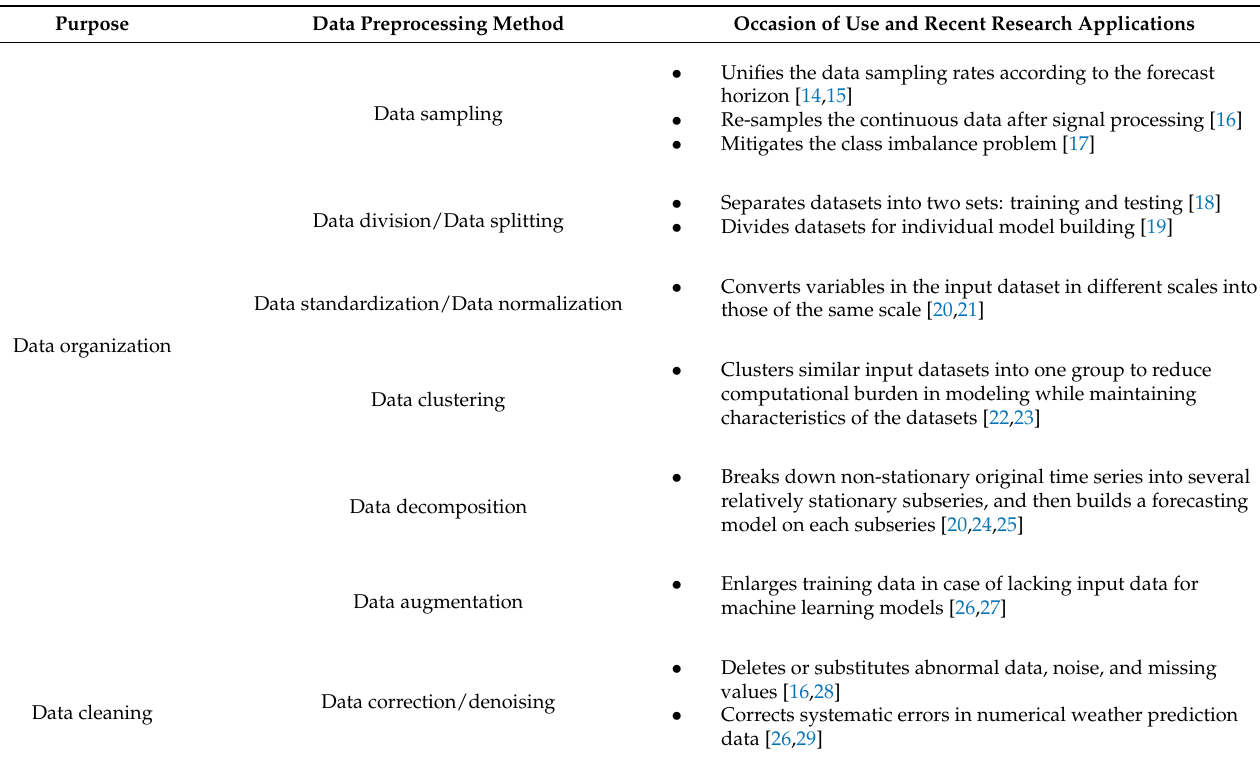
Table 1. Summary on data preprocessing methods and their recent research applications in wind power forecasting from the